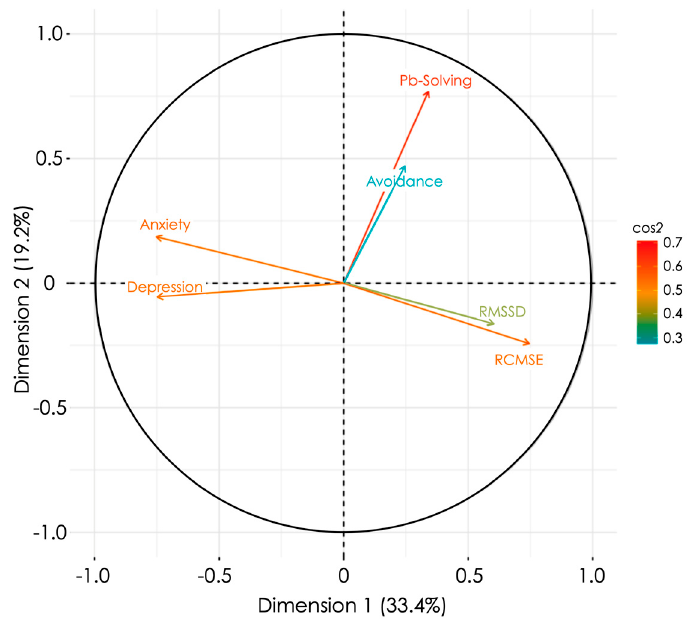
Figure 5. Principal component analysis of mixed data with the two main dimensions projected on orthogonal axes. Anxiety and Depression scores were calculated from the Hospital Anxiety and Depression Scale (HADS). Problem solving (Pb-Solving) and avoidance represent the two Brief-COPE subscales that reached significant difference among the tested populations. RMSSD represent the heart rate variability in short-range dynamics, and RCMSE represents the complexity in nonlinear dynamics of heart rate variability. Only quantitative variables are represented in the figure.